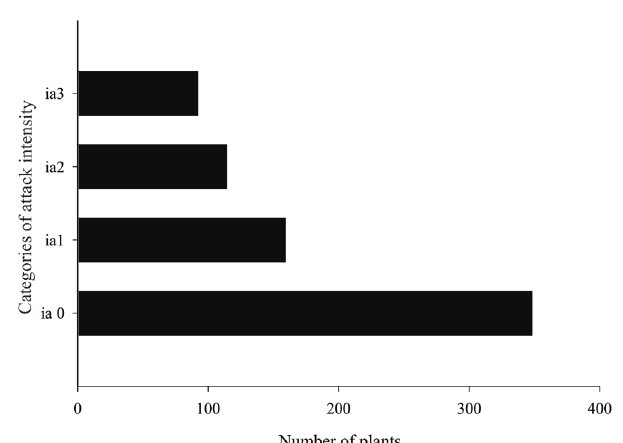
Fig 3. Number of individuals in each category of intensity of attack ( ia ) of termites in the vegetation of the Cerrado of the Estação Ecológica de Pirapitinga - Minas Gerais. ia0 : Absence of termites; ia1 : Presence of termites without attack; ia2 : Attack limited to the bark; and ia3 : Severe attack.